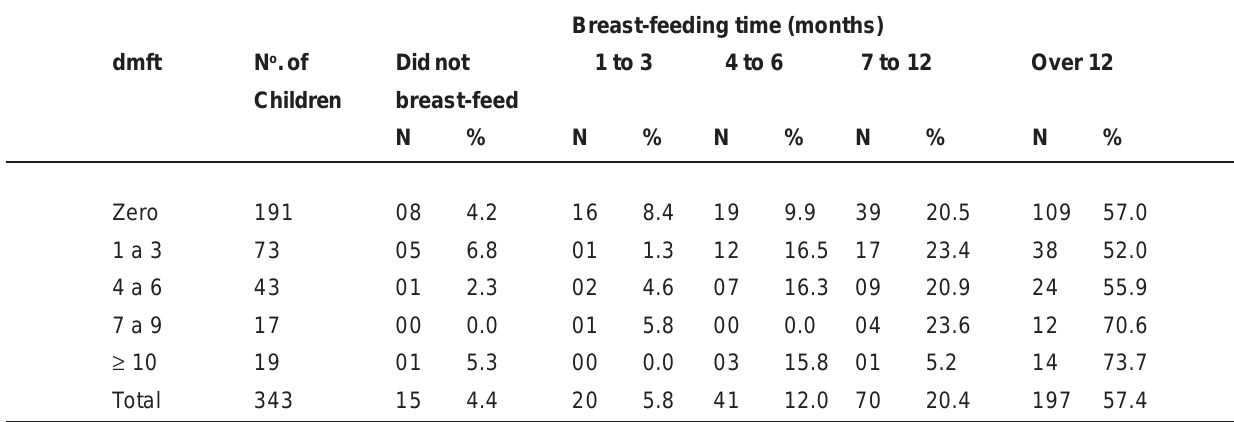
TABLE 3- Breast-feeding time and dmft index. Federal University of Piauí,